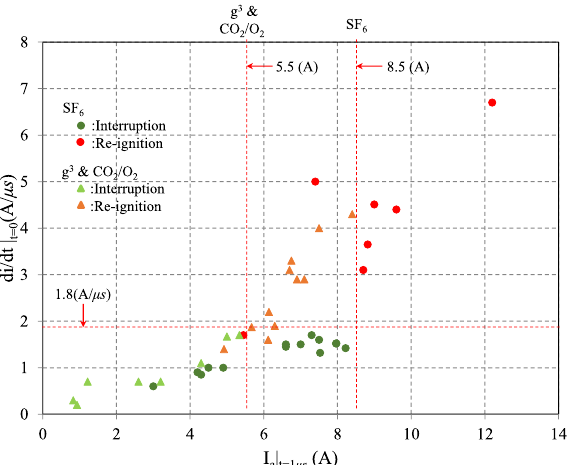
Figure 7. Comparison of interrupting performance according to SF 6 , CO 2 /O 2 , and g 3 gases (The di/dt value at zero cross point according to change in I a value at the time point of 1 µ s).